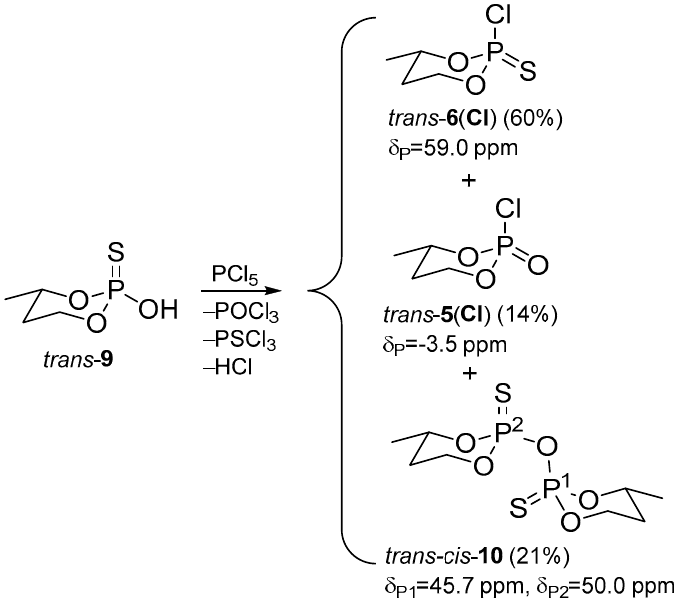
Scheme 7. Structure of products formed in reaction between phosphorus pentachloride and thio- phosphoric acid trans - 9 .